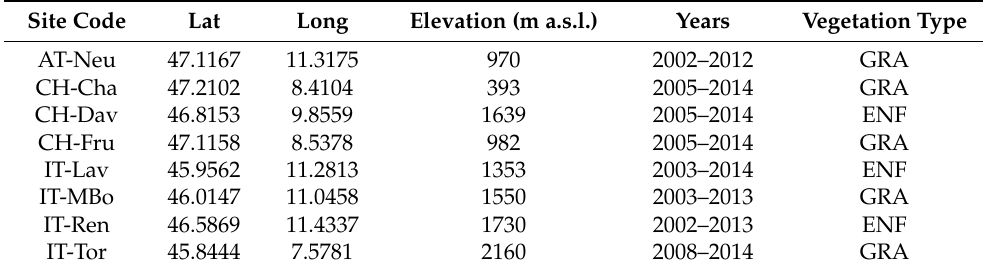
Table 1. FLUXNET stations used in this study, including site code, coordinates, elevation, years of measurement used for the analysis, and vegetation type (from https://fluxnet.fluxdata.org/data/ fluxnet2015-dataset/, accessed on 29 April 2021). Site Code Lat Long Elevation (m a.s.l.) Years Vegetation Type AT-Neu